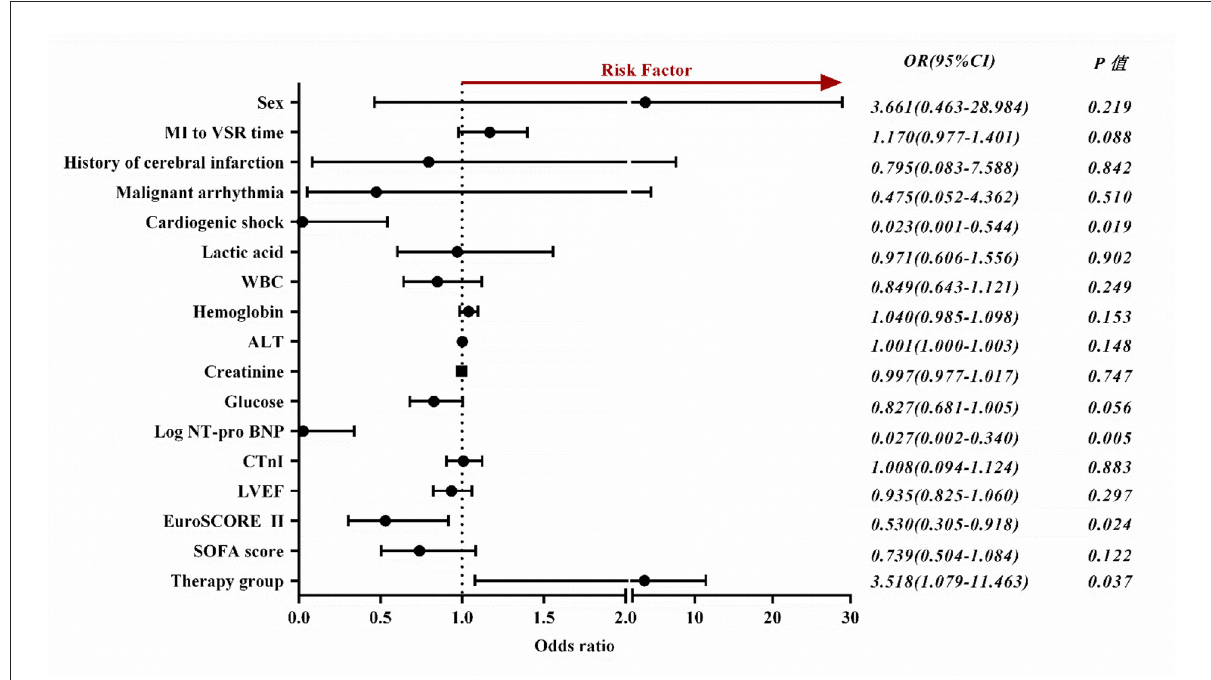
FIGURE2 Forest plot depicts factors influencing the long-term prognosis of patients with VSR. OR, odds ratio; CI, confidence interval; MI, myocardial infarction; VSR, ventricular septal rupture; WBC, white blood cells; ALT, alanine transaminase; NT-pro BNP, n-terminal pro b-type natriuretic peptide; CTnI, cardiac troponin I; LVEF, left ventricle ejection fraction; SOFA, sequential organ failure assessment.